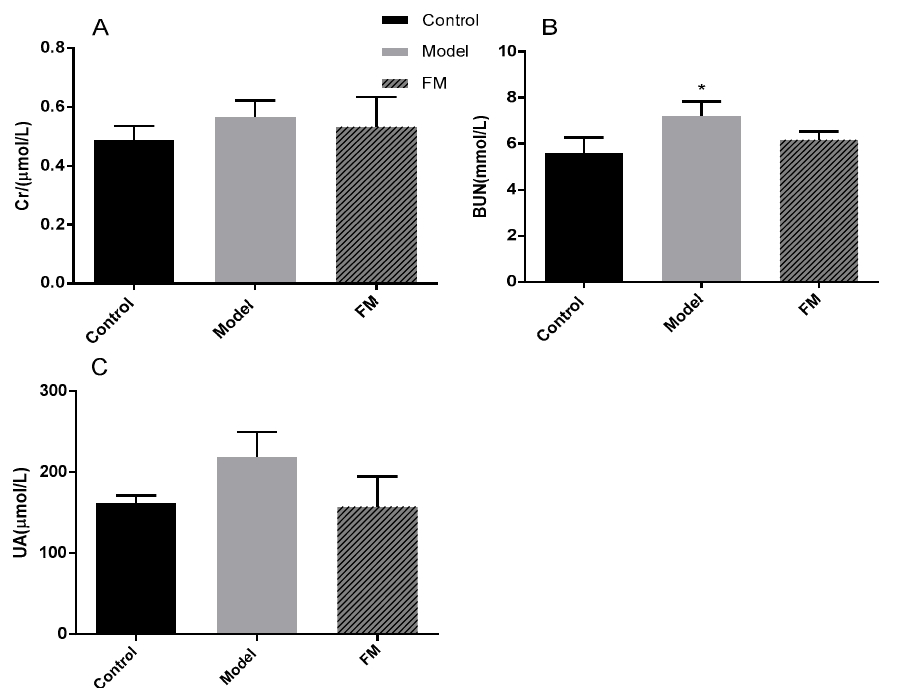
Figure 5. Effects of FM on serum Cr ( A ), BUN ( B ) and UA ( C ) levels. * p < 0.05 vs. control group.